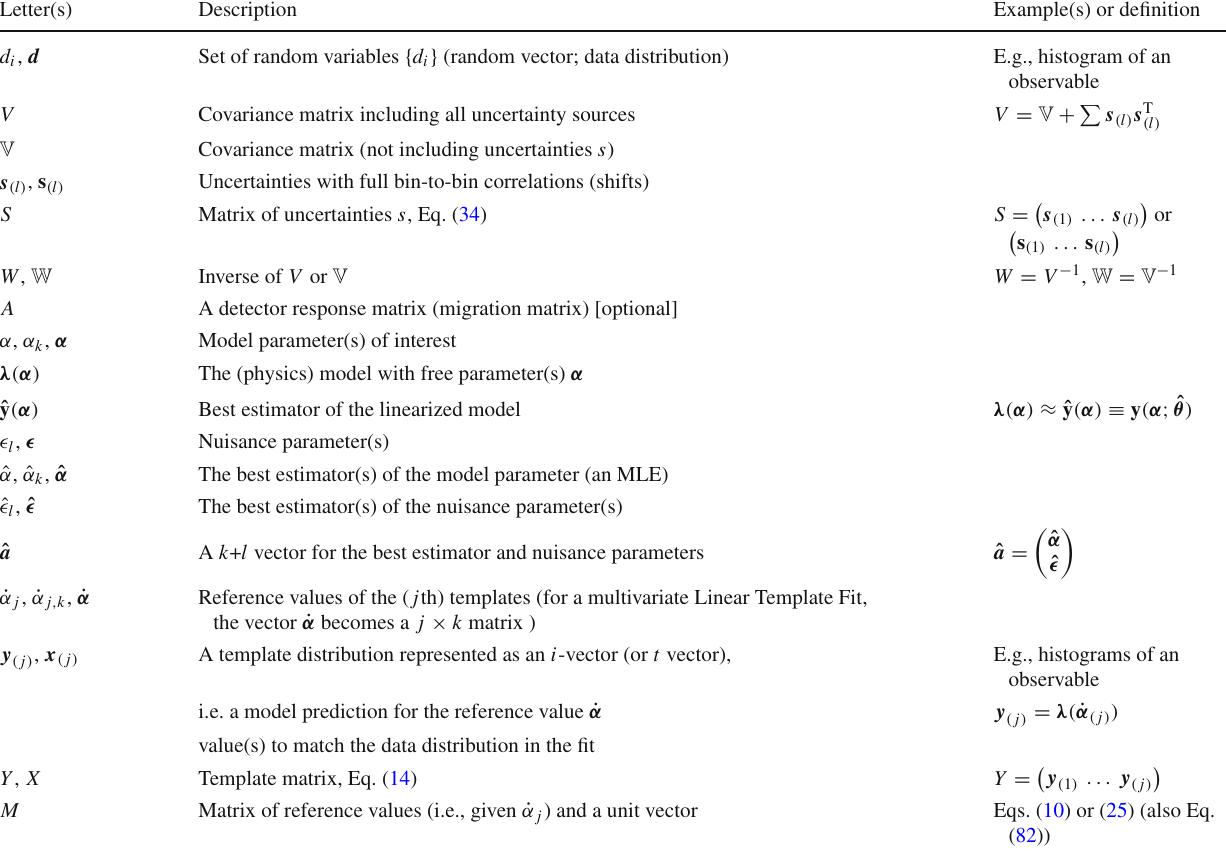
Table 3 Summary of the notation used. Capital letters denote a matrix, and small bold letters denote a column vector. The letters i , j , k , l , and t are indices. Throughout this article, a vector notation is used and, for instance, the vector d denotes a set of (random) variables, so d = { d i } . The same letters for indices and for the maximum value of an index are used. A subscript index denotes the entry of a vector (or matrix), and a bracketed index denotes one vector out of several others. Some let-